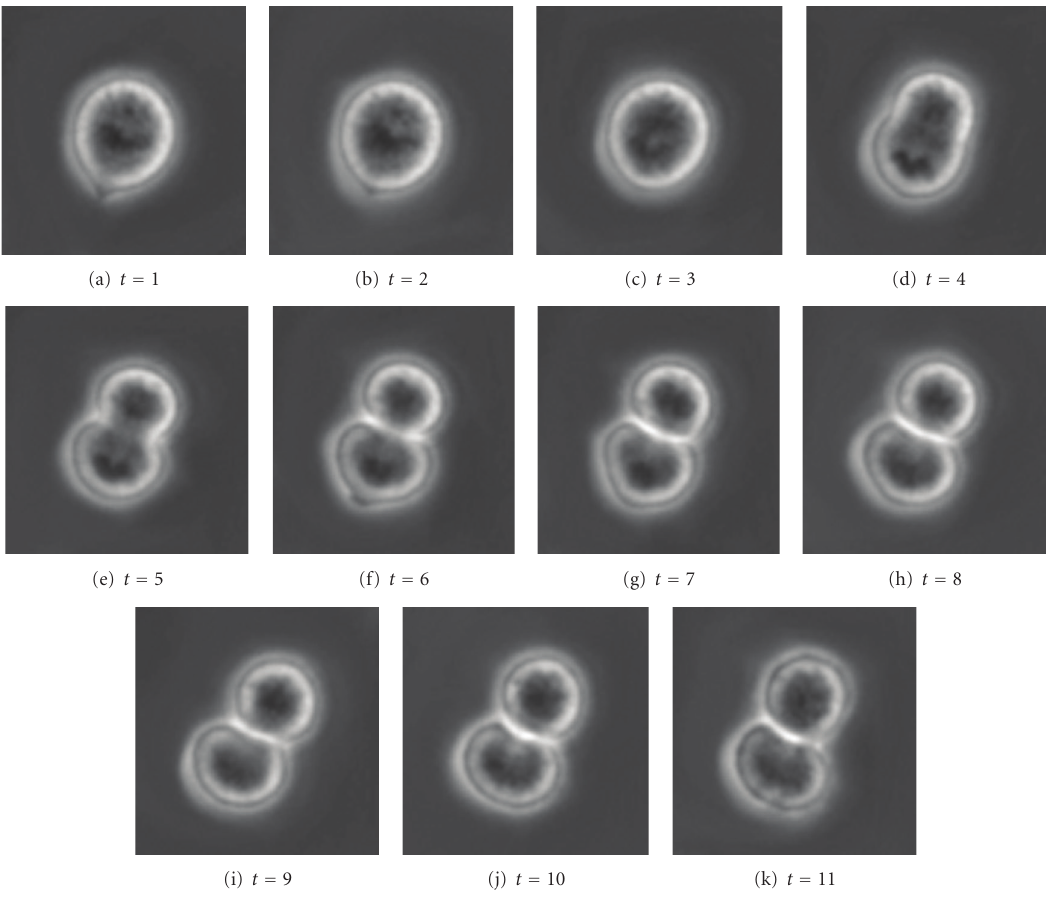
Figure 19: Original image